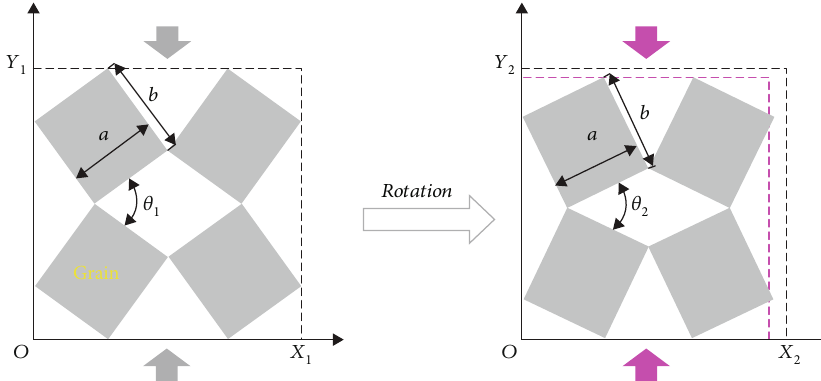
Figure 14: Crystal grains structure model and rotation mechanism of negative Poisson ’ s ratio (modi fi ed from